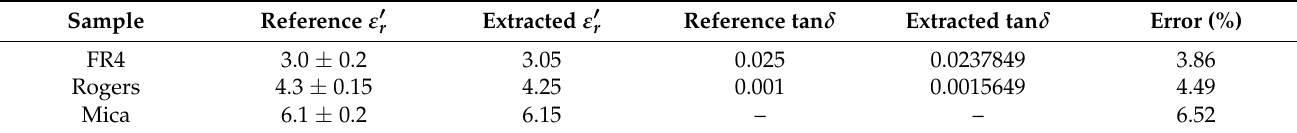
Table 3. Measurement analysis of the designed sensor based on error ratio for the different permittivity MUTs.